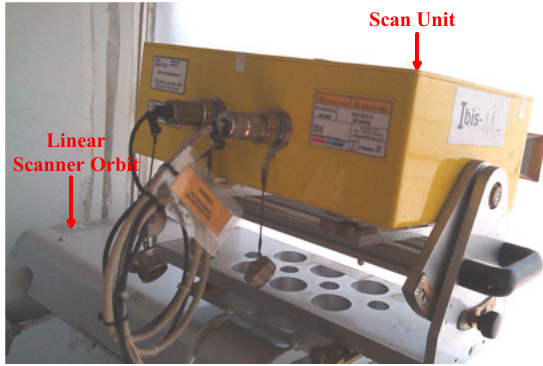
Figure 5. Synthetic aperture radar and linear rail unit module.